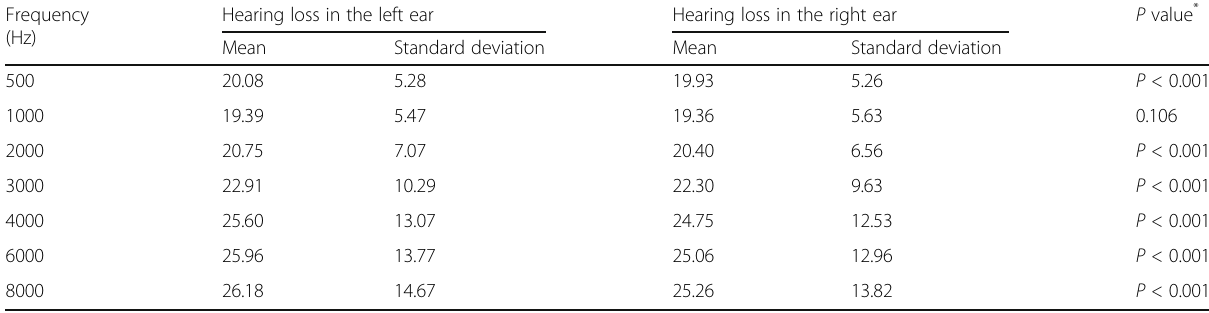
Table 2 Mean and standard deviation of the hearing loss in the left and right ears at the different frequencies Frequency Hearing loss in the left ear Hearing loss in the right ear P value (Hz)